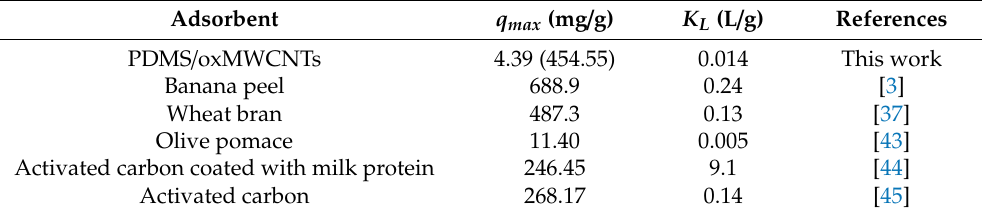
Table 1. Langmuir constants for PCs adsorption from various absorbents reported in